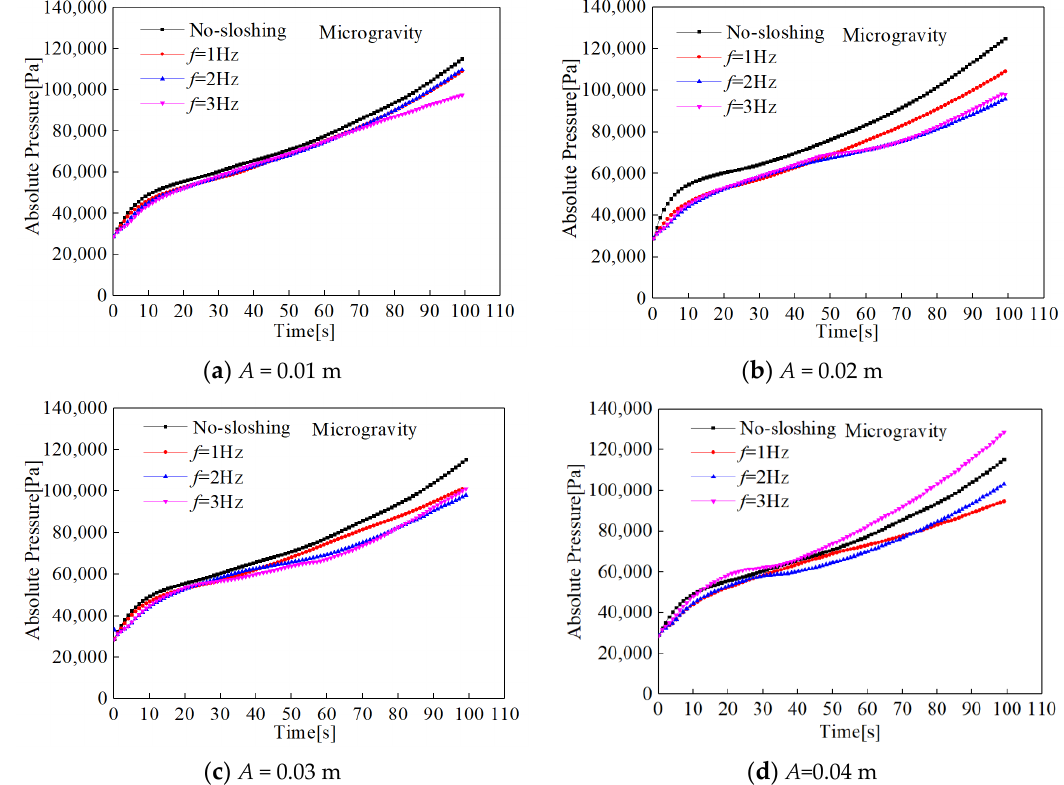
Figure 16. Pressure responses of the no-vent filling process under different sloshing frequencies and microgravity with the condition of sloshing amplitude ( a ) A = 0.01 m, ( b ) A = 0.02 m, ( c ) A = 0.03 m, and ( d ) A = 0.04 m.